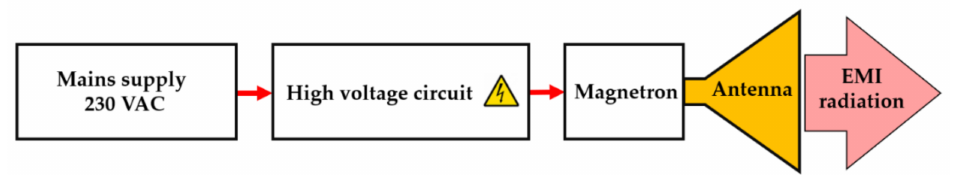
Figure 3. Basic block diagram of a microwave power generator.